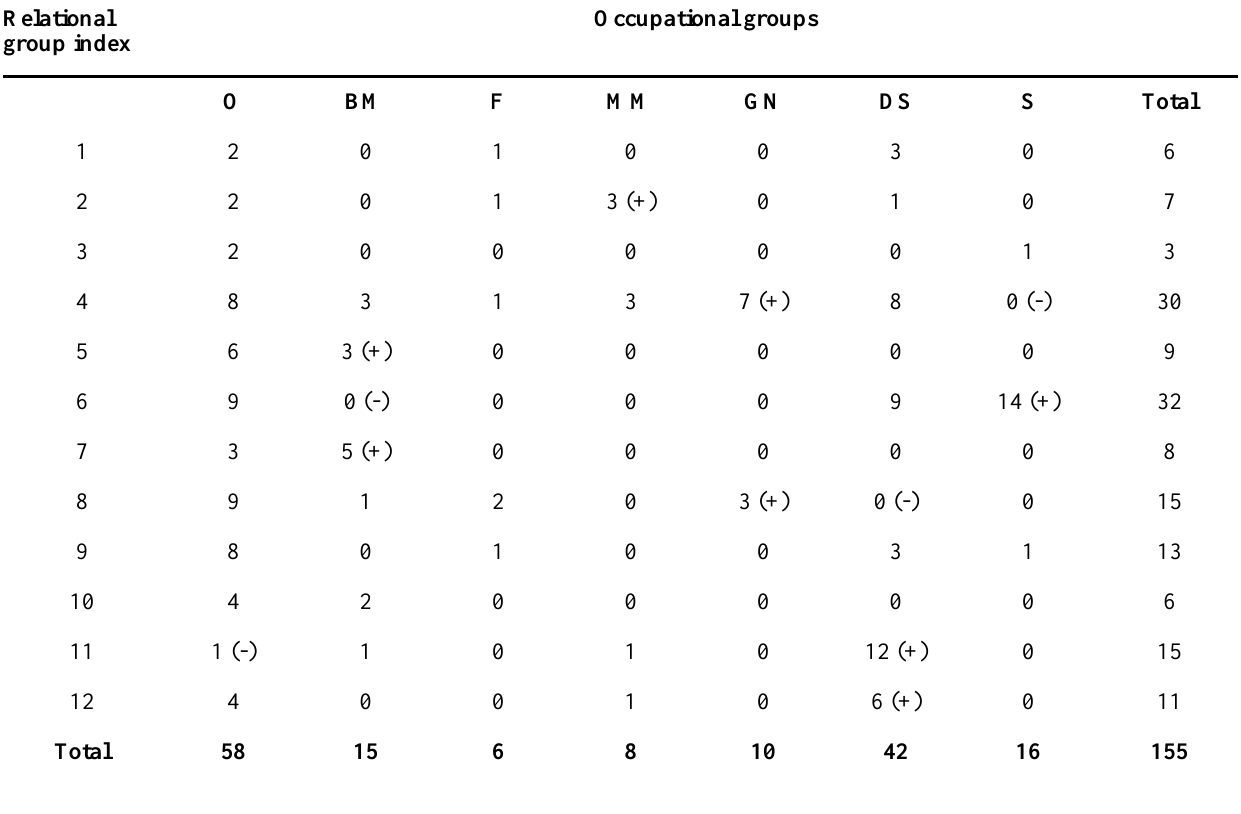
Table 4. Cross-table of occupational and relational groups. The values represent the count of individuals for each combination. The P -value assuming no interaction between occupation and group membership > 0.0001. Absolute values of adjusted standardized residuals ‡ 2.0 are an indication of a significant interaction between membership in the relational group and the occupational category, and are marked with a plus or a minus sign. Plus signs indicate an overrepresentation of a particular occupational category in a relation group, whereas the opposite applies for minus signs. O = Other, BM = Businessman, F = Farmer, MM = Middleman, GN = Gill Net fisherman, DS = Deep Sea fisherman, and S = Seine Net